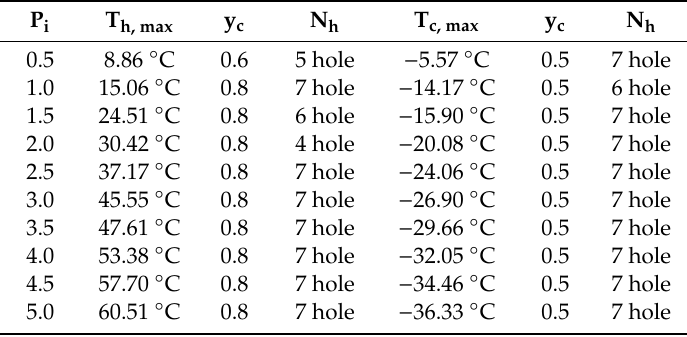
Table 3. T h, max and T c , max of y c and nozzle holes depending on the pressure.